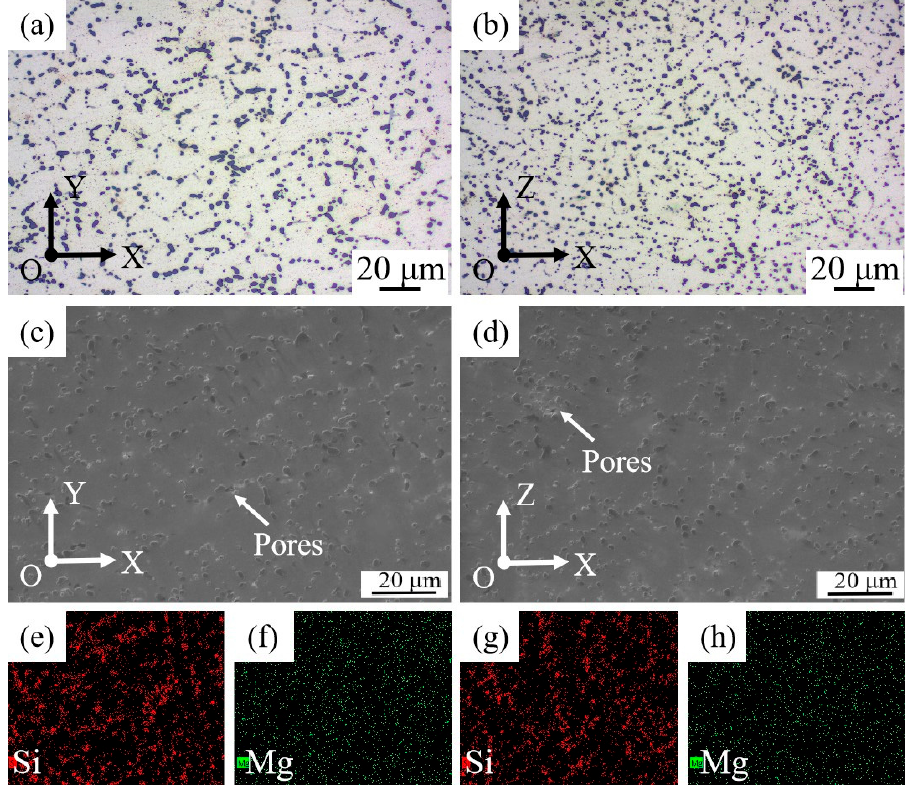
Figure 5. Metallographic morphology, SEM and EDS graphs of the T6 heat-treated samples: ( a ) face XOY; ( b ) face XOZ; ( c ) face XOY; ( d ) face XOZ; ( e , f ) Distribution of Si, Mg elements of ( c ) respectively; ( g , h )Distribution of Si, Mg elements of ( d ) respectively.